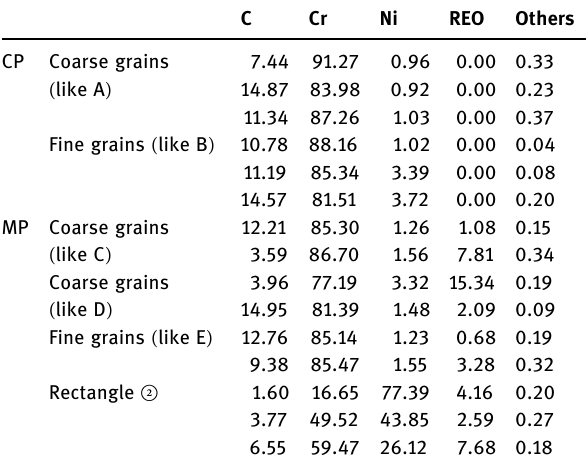
Table 2: Elemental composition of speci fi c regions of Cr 3 C 2 – NiCr powders ( wt% ) C Cr REO Others